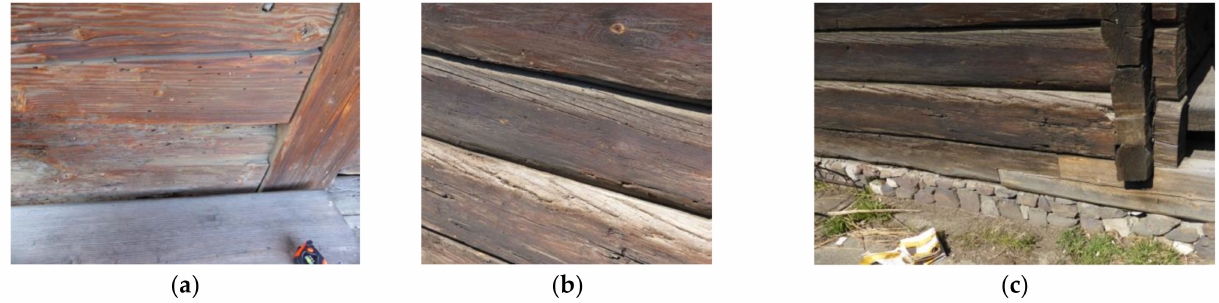
Figure 23. Biological infestation of wood: ( a ) exit hole of the insect, Common Furniture Beetle (Anobium punctatum); ( b ) exit holes of the insect, House Longhorn Beetle (Hylotrupes bajulus); ( c ) brown decay of the sill beam (part of which has been replaced with a new one) and the beam immediately above